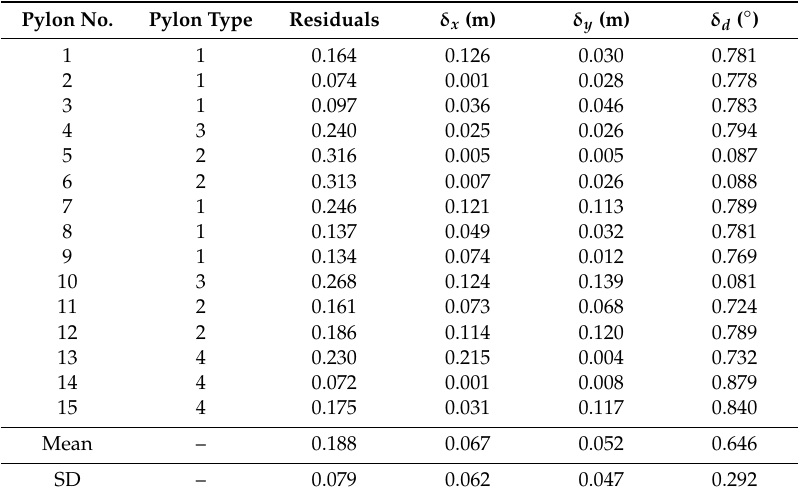
Table 4. The accuracy of pylon body